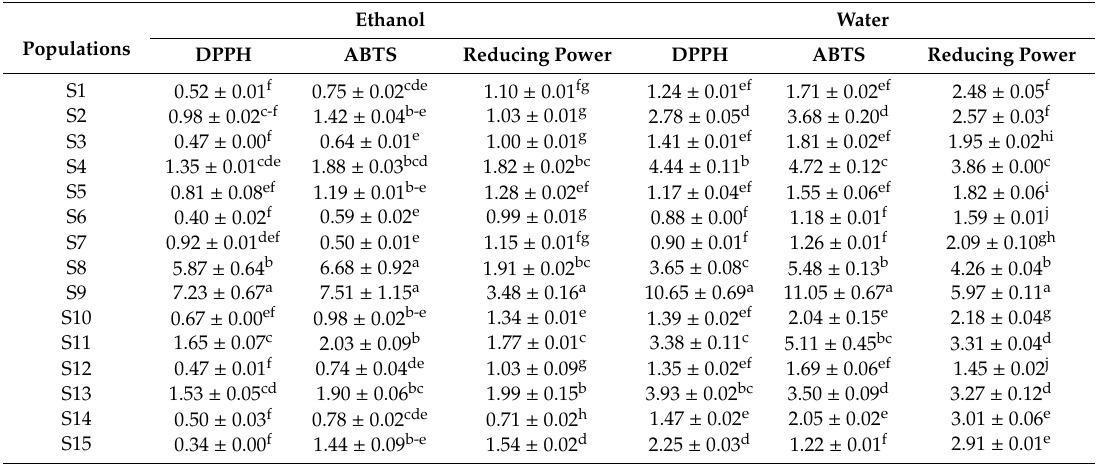
Table 4. The antioxidant activity of ethanol and water extracts of C. paliurus